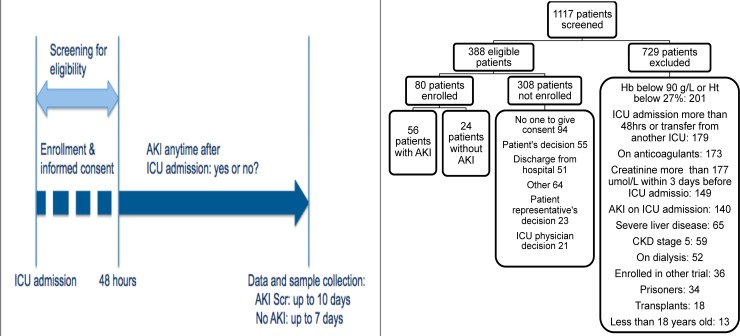
a and b.Screening, enrollment procedures and follow-up of study patients. AKI: acute kidney injury, AKI Scr: acute kidney injury based on serum creatinine criterion, CKD: chronic kidney disease, Hb: hemoglobin, Ht: hematocrit, ICU: intensive care unit. Reasons for exclusion can include more than 1 criterion.